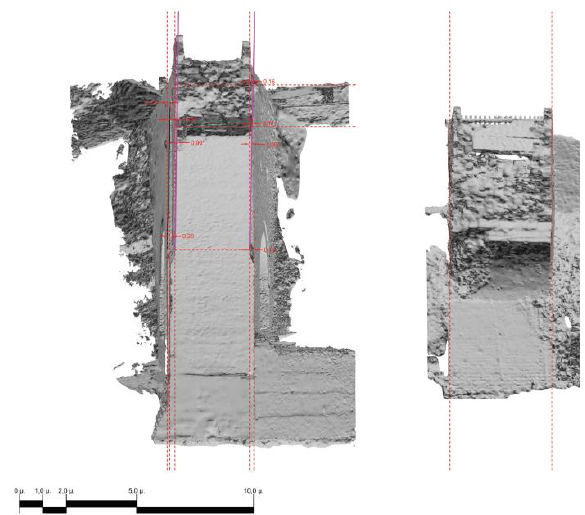
Figure 9. Deformation study of west (left) and east (right) sections of the remains of the Bridge based on the 3D mesh geometry.